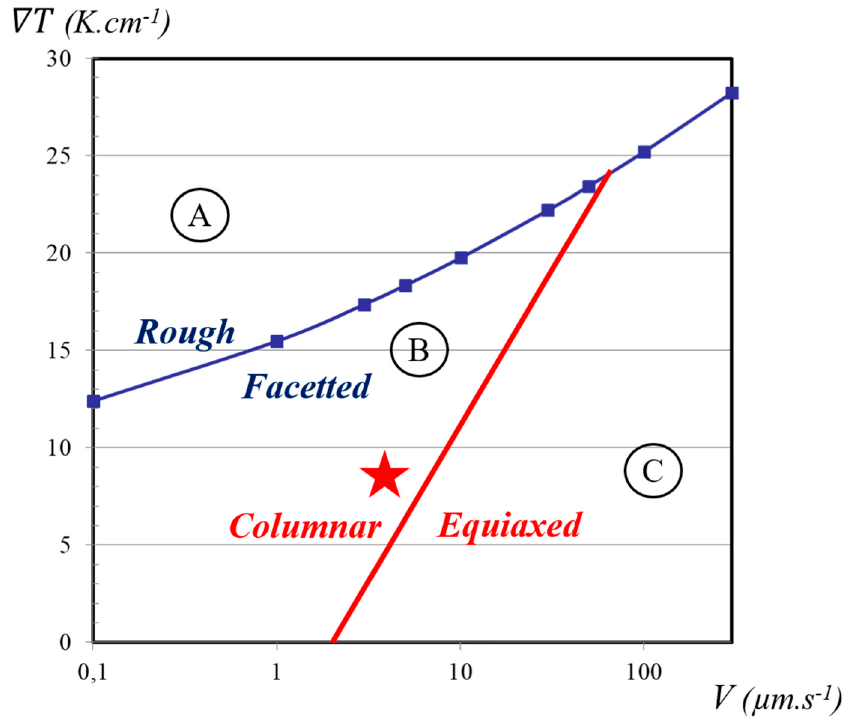
Figure 7. Diagram showing the various zones where typical grain structures appear in Photovoltaic Si